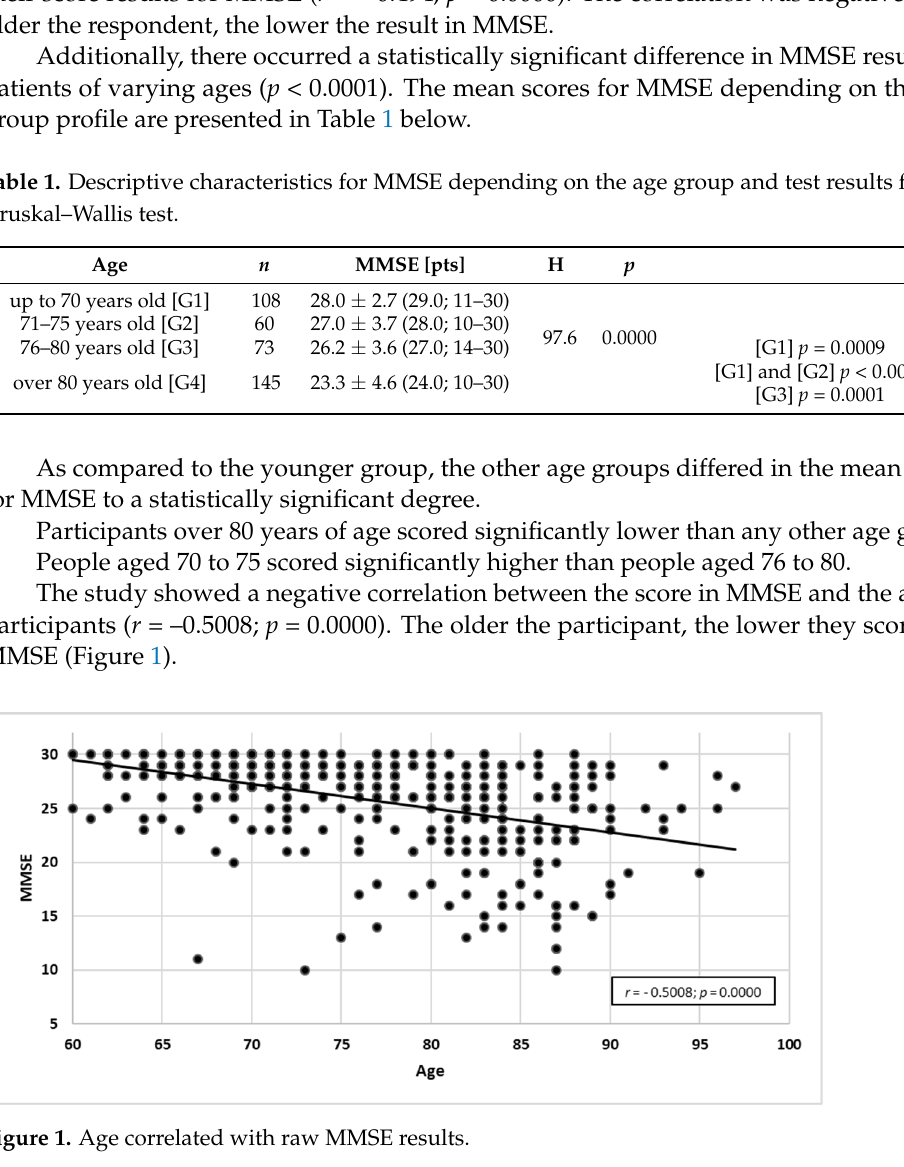
Figure 2. Years of schooling correlated with raw MMSE data. 3.2.2. ACE-III On average, the full-scale ACE-III score (within the range of 0–100 points) was 78.5 ± 16.8 (84.0; 25.0–99.0). For each component corresponding to a particular domain, the average score was: • Attention (pts)—15.5 ± 2.9 (17.0; 5.0–18.0), range 0–18 pts; •